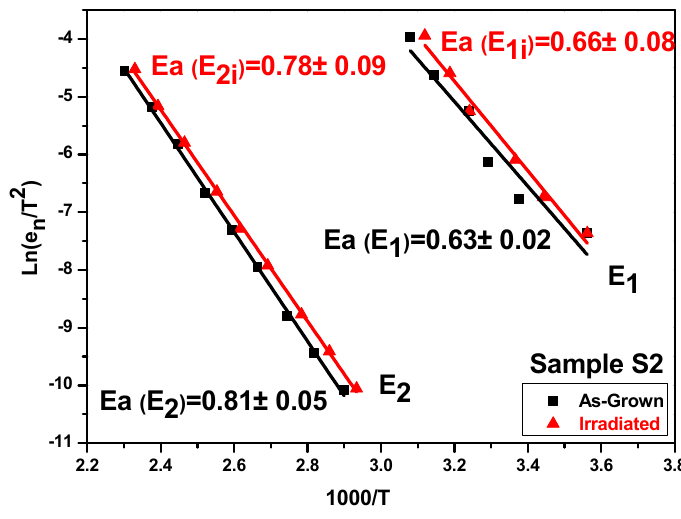
Figure 5. Arrhenius plots of the electron traps depicted in Figure 4 where the DLTS spectra were recorded for sample S2 with the following parameters: V R = − 0.5 V, V P = 0V and the duration of the filling pulse was t p = 1 ms at rate window 500 s − 1